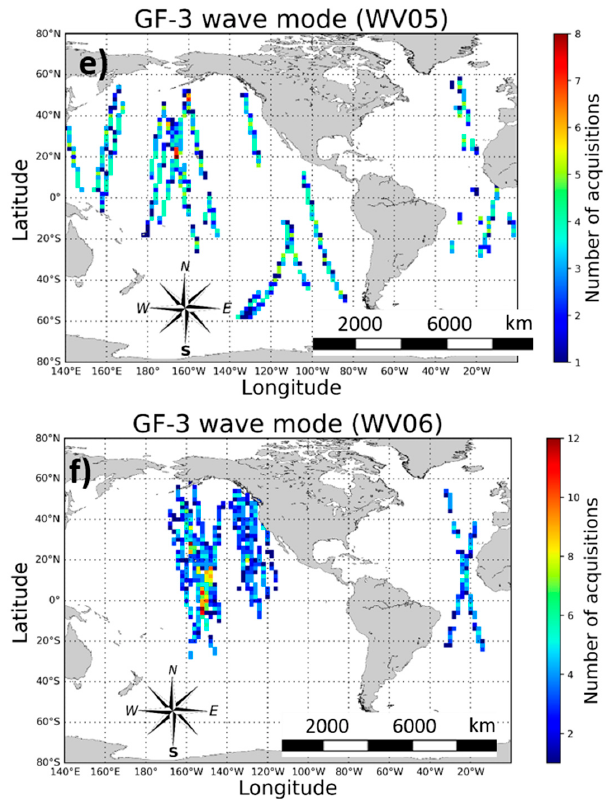
Figure 2. Maps for GF-3 SAR WM acquisitions in data density for 2 ° × 2 ° bins for WV01 ( a ), WV02 ( b ), WV03 ( c ), WV04 ( d ), WV05 ( e ) and WV06 ( f ) from January to October 2017.